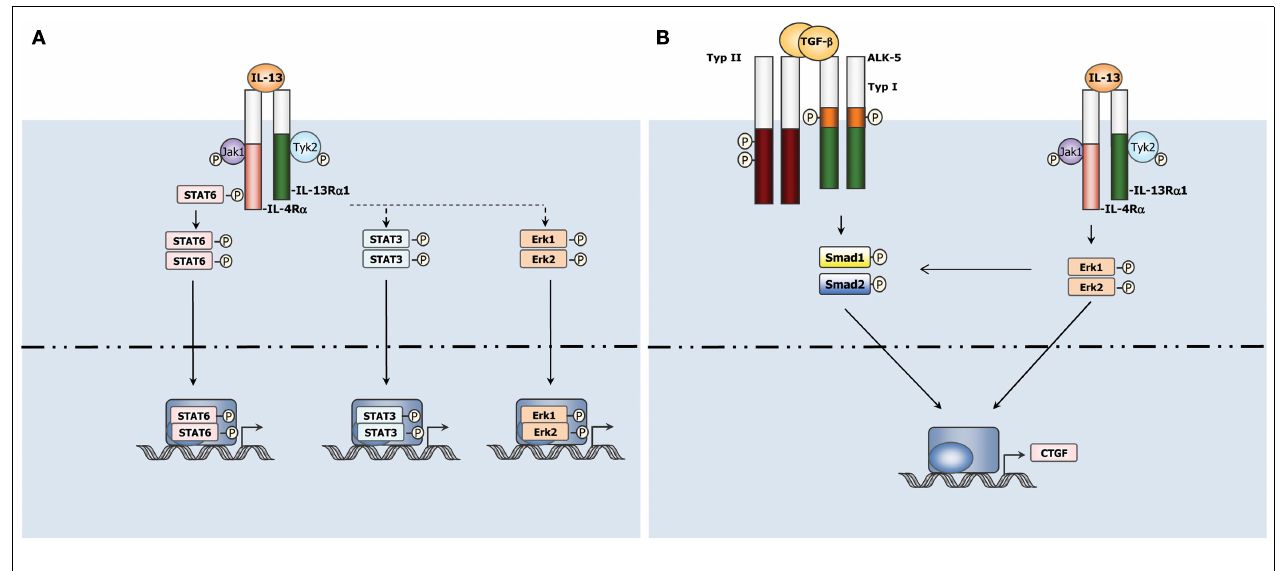
(B) Non-canonical signaling pathways of IL-13 play a critical role in liver fibrosis. IL-13 interacts withTGF- β signaling pathway to induce CTGF expression in HSCs via Erk1/2 pathway (Liu et al.,